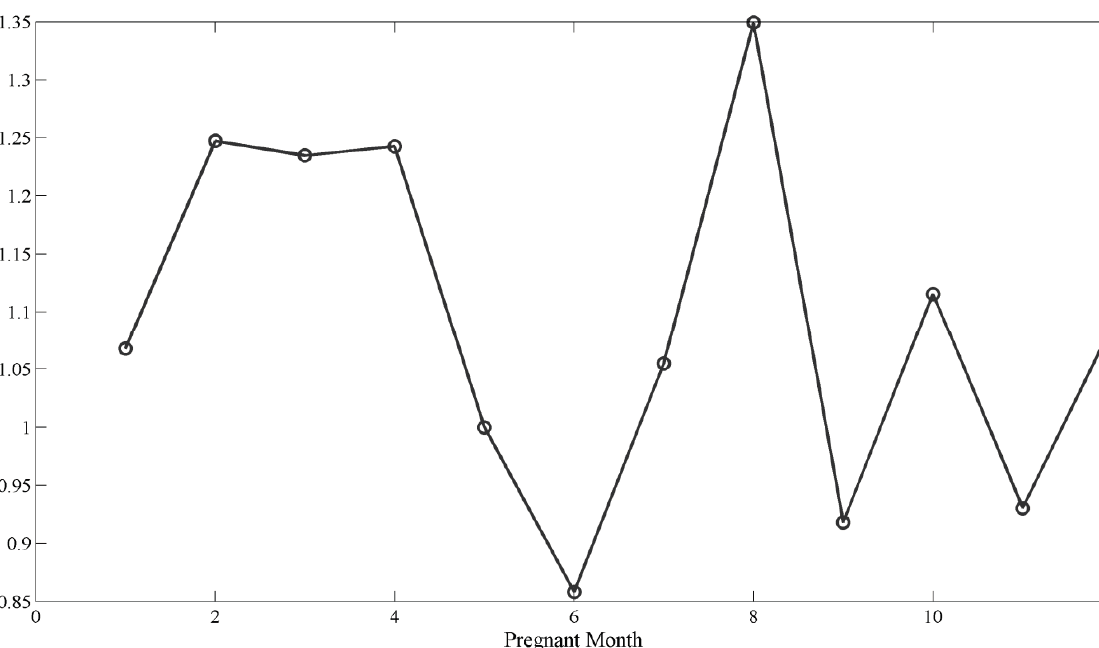
Figure 1. Birth-sex ratio (male/female) by mother pregnancy